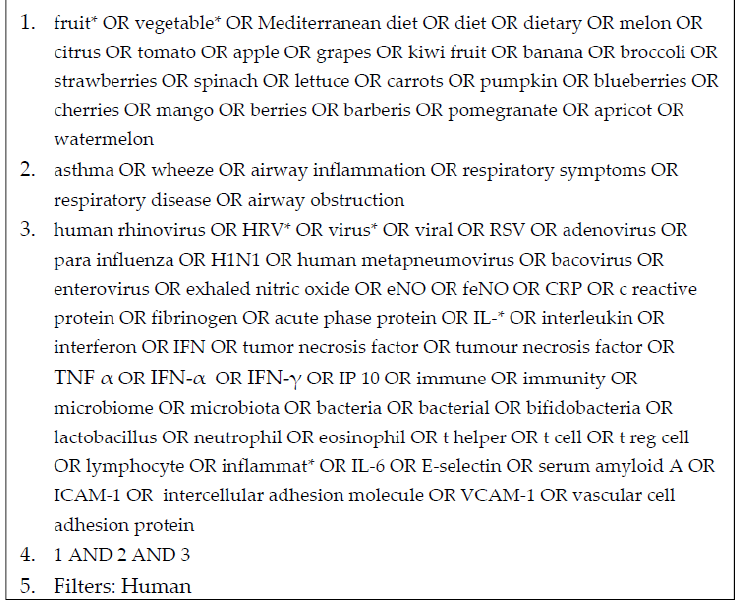
Figure 1. Example of search strategy using PubMed for studies investigating the effects of fruit and vegetable consumption on immune responses (including immune responses to virus infection, and inflammation) and clinical outcomes in asthma.